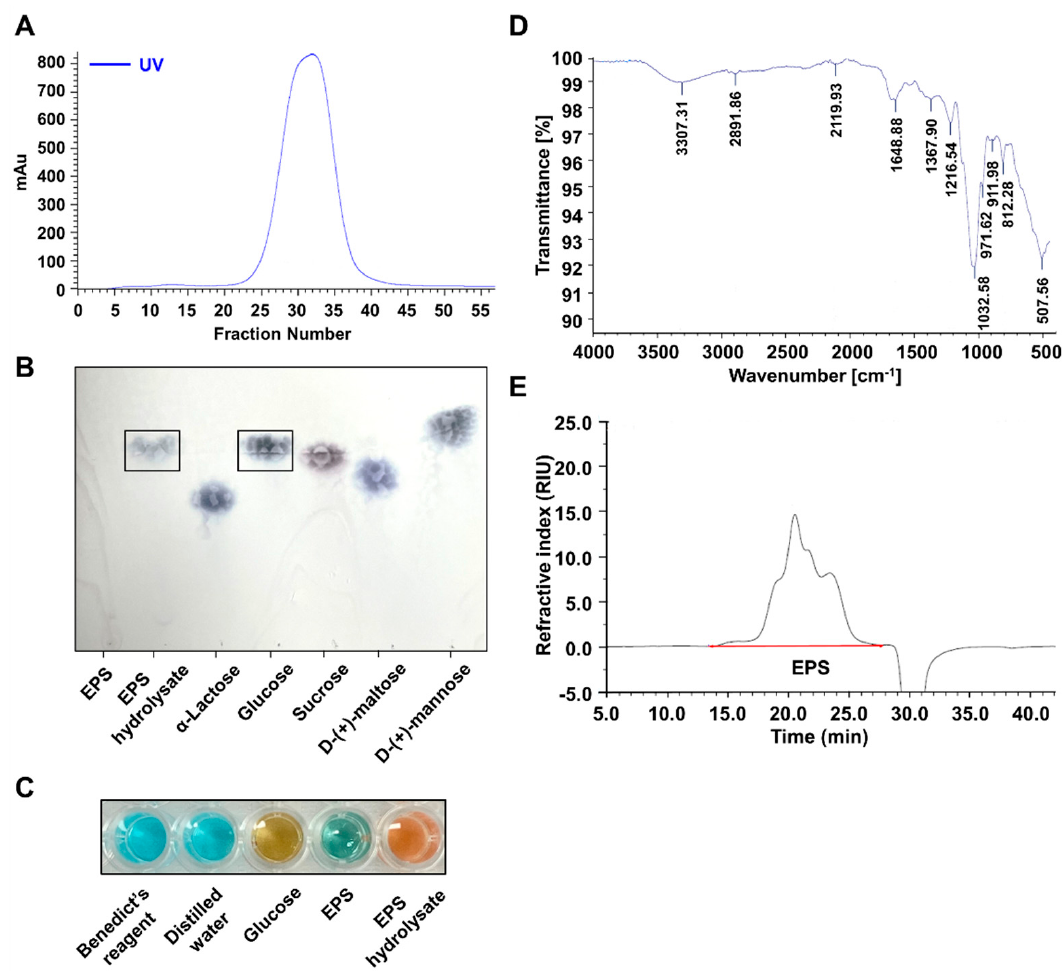
Figure 2. Exopolysaccharide (EPS) isolated from L-14 was polysaccharide mainly composed of glucose. ( A ) EPS isolated from L-14 culture media was identified as a homogeneous